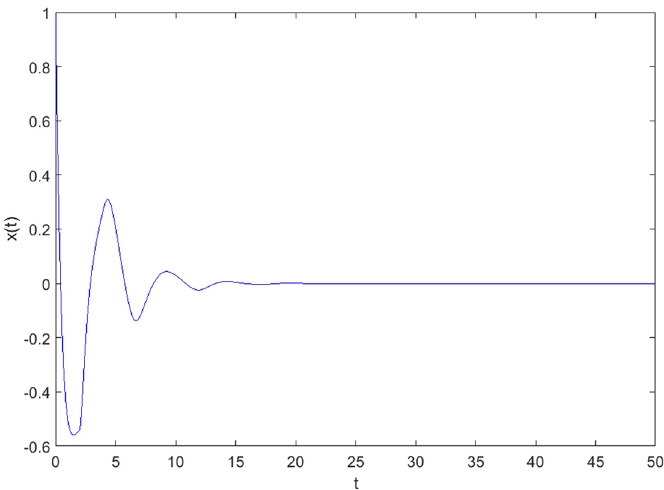
Figure 2: Numerical solution x t ( ) of equation ( 6.2 ) for initial value ϕ t 1 ( ) ≡